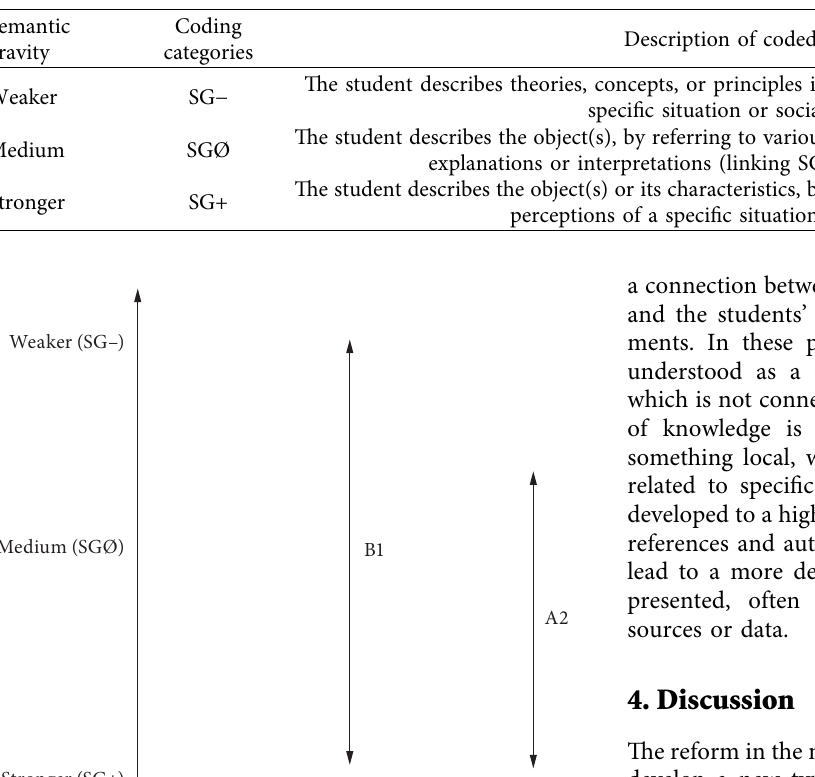
Table 1: A translation device for semantic gravity.